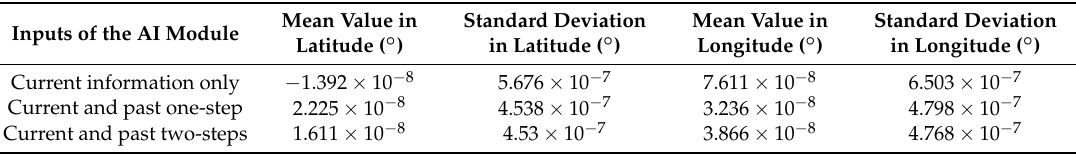
Figure 7. Prediction error of the position increment in latitude using different steps. Table 1. Prediction errors of different